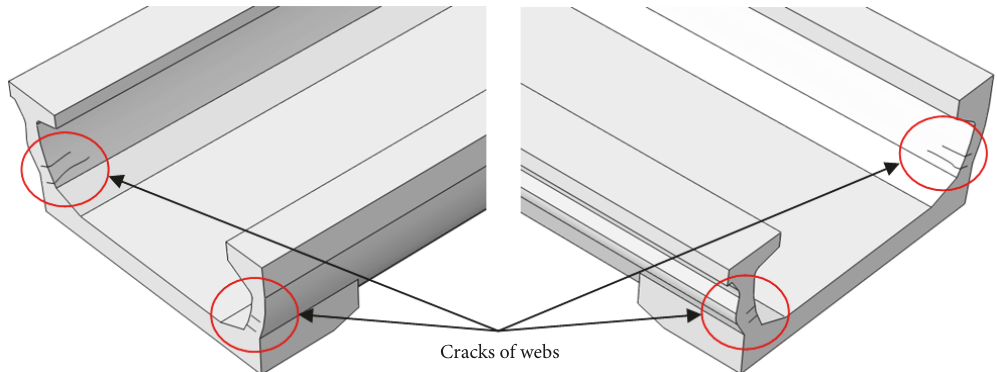
Figure 6: Crack details and overall crack patterns of